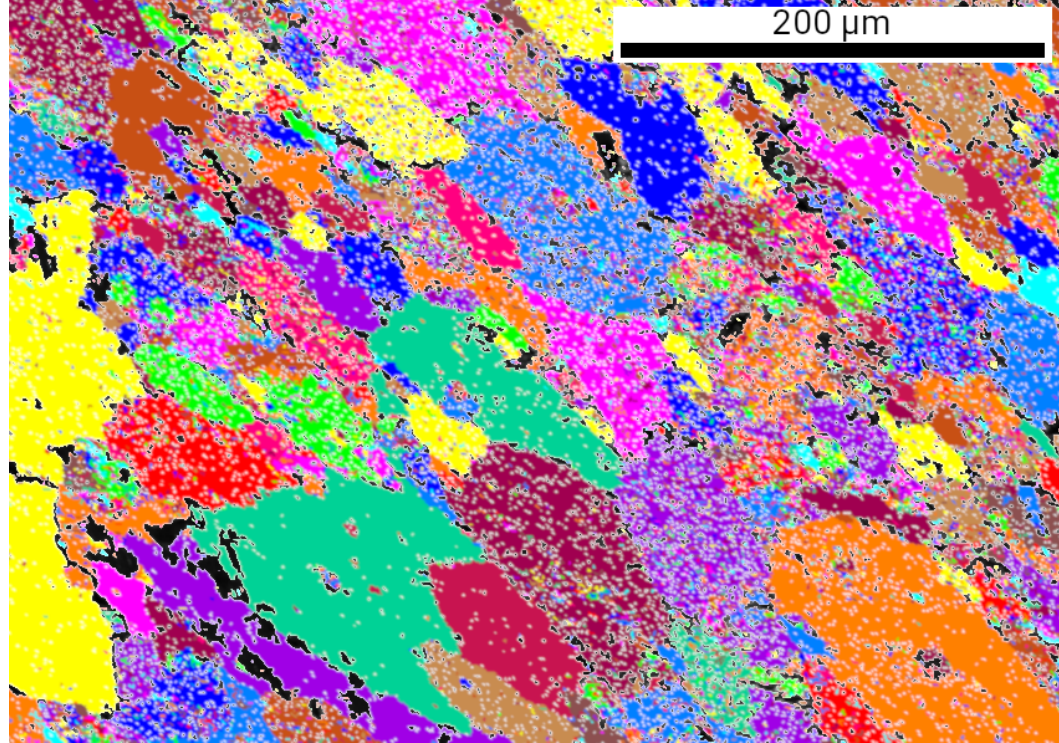
Figure 8. EBSD image on the microstructure obtained on the “es” side of the CYS04 film heated up to 1000